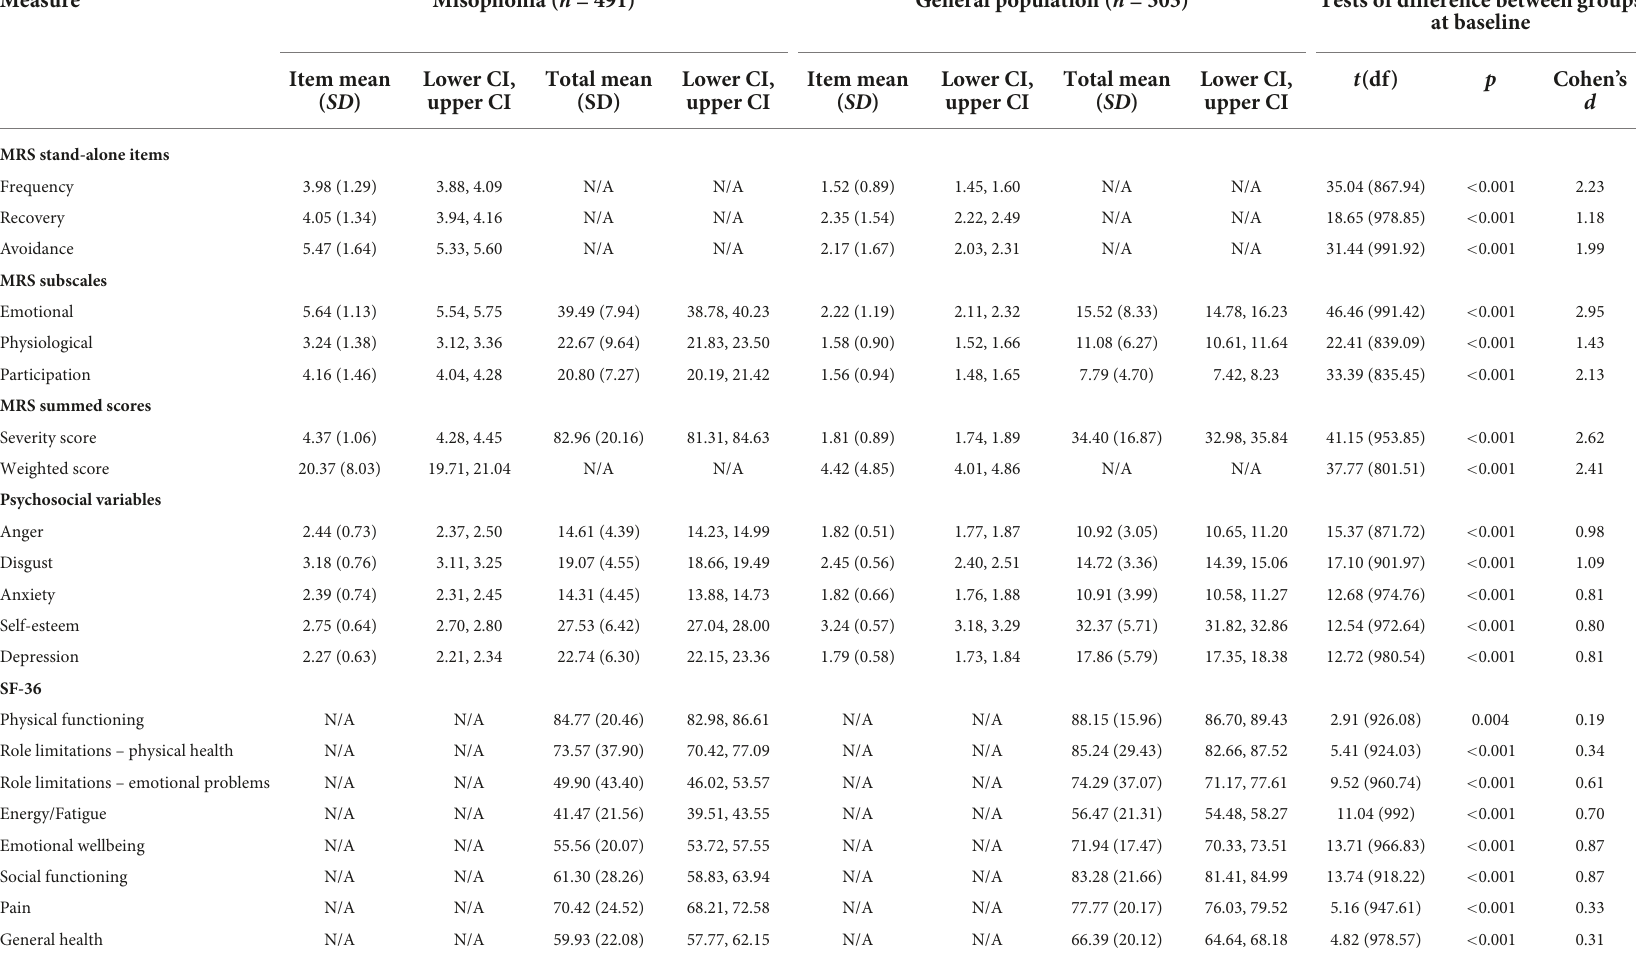
TABLE 5 Descriptive statistics and between-group tests of difference for misophonic responses, psychosocial variables, and quality of life at